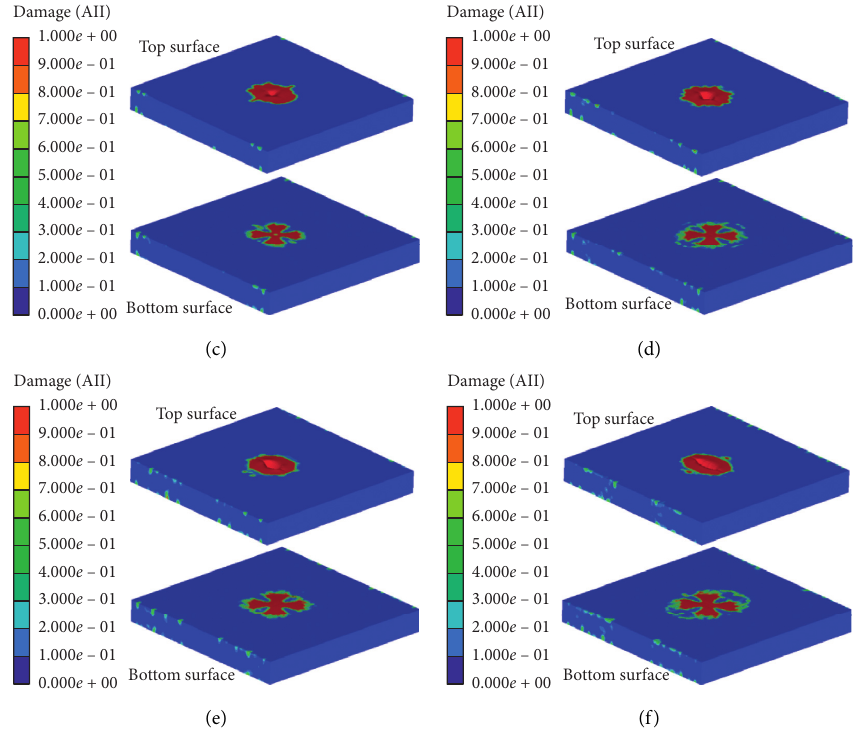
Figure 19: Damage features of the RC slabs under spherical and cylindrical explosives. (a) Spherical explosive. (b) Cylindrical explosive with L/D � 0.2. (c) Cylindrical explosive with L/D � 0.6. (d) Cylindrical explosive with L/D � 1.0. (e) Cylindrical explosive with L/D � 2.0. (f) Cylindrical explosive with L/D �